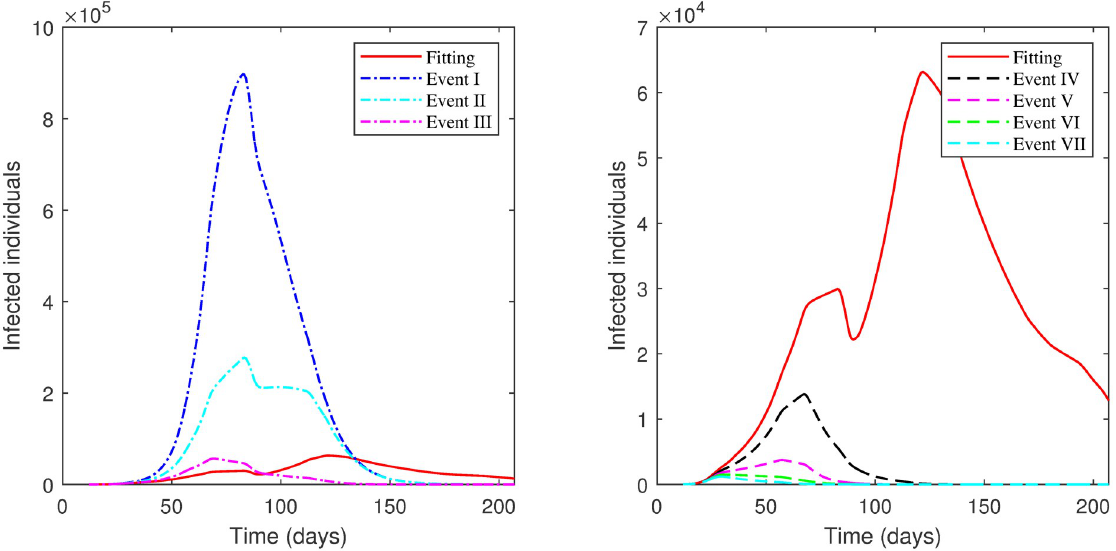
Fig 14. Numerical solution of model (1) for infected compartment vs. time for 2 nd scenario of Second Case.